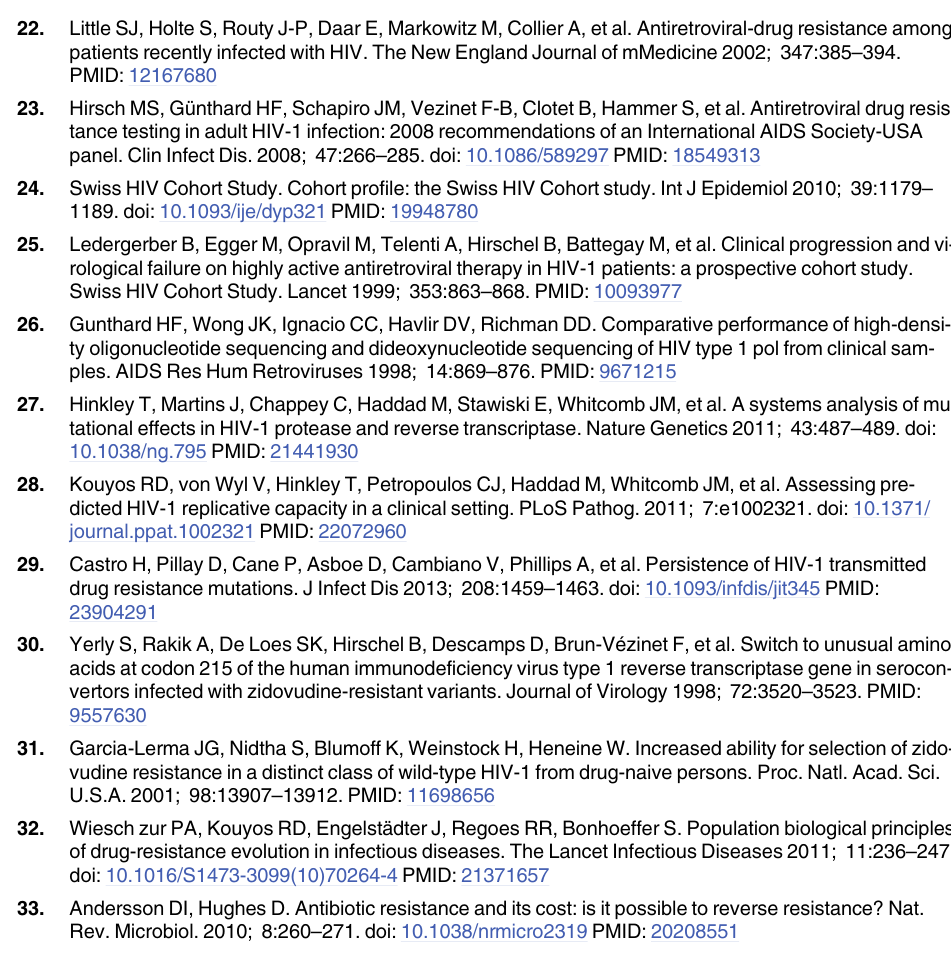
PLOS Pathogens | DOI:10.1371/journal.ppat.1004722 March 23,